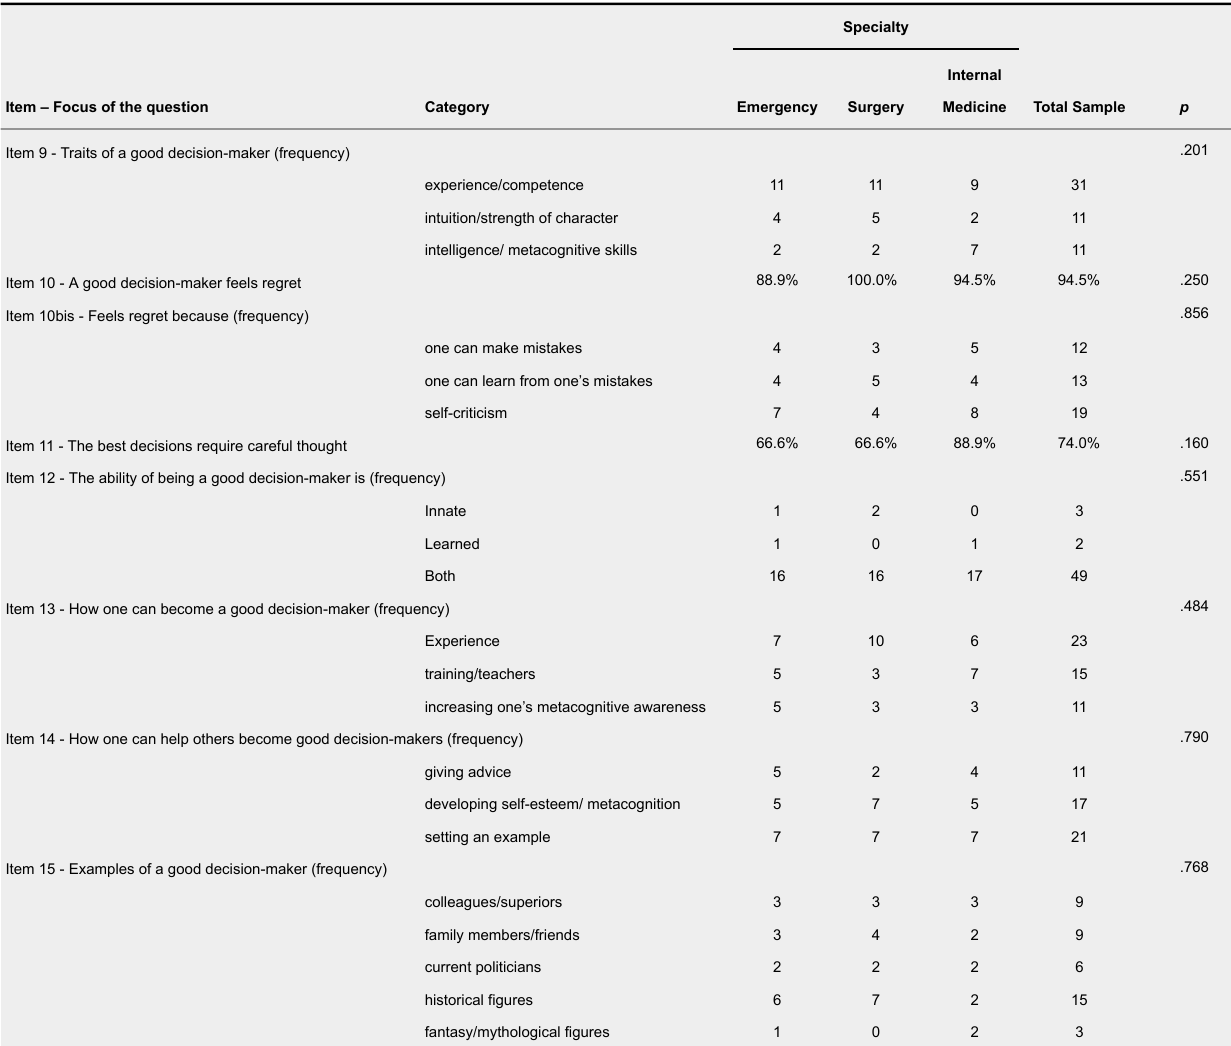
Responses to Questions in the Second Part of the Questionnaire, According to